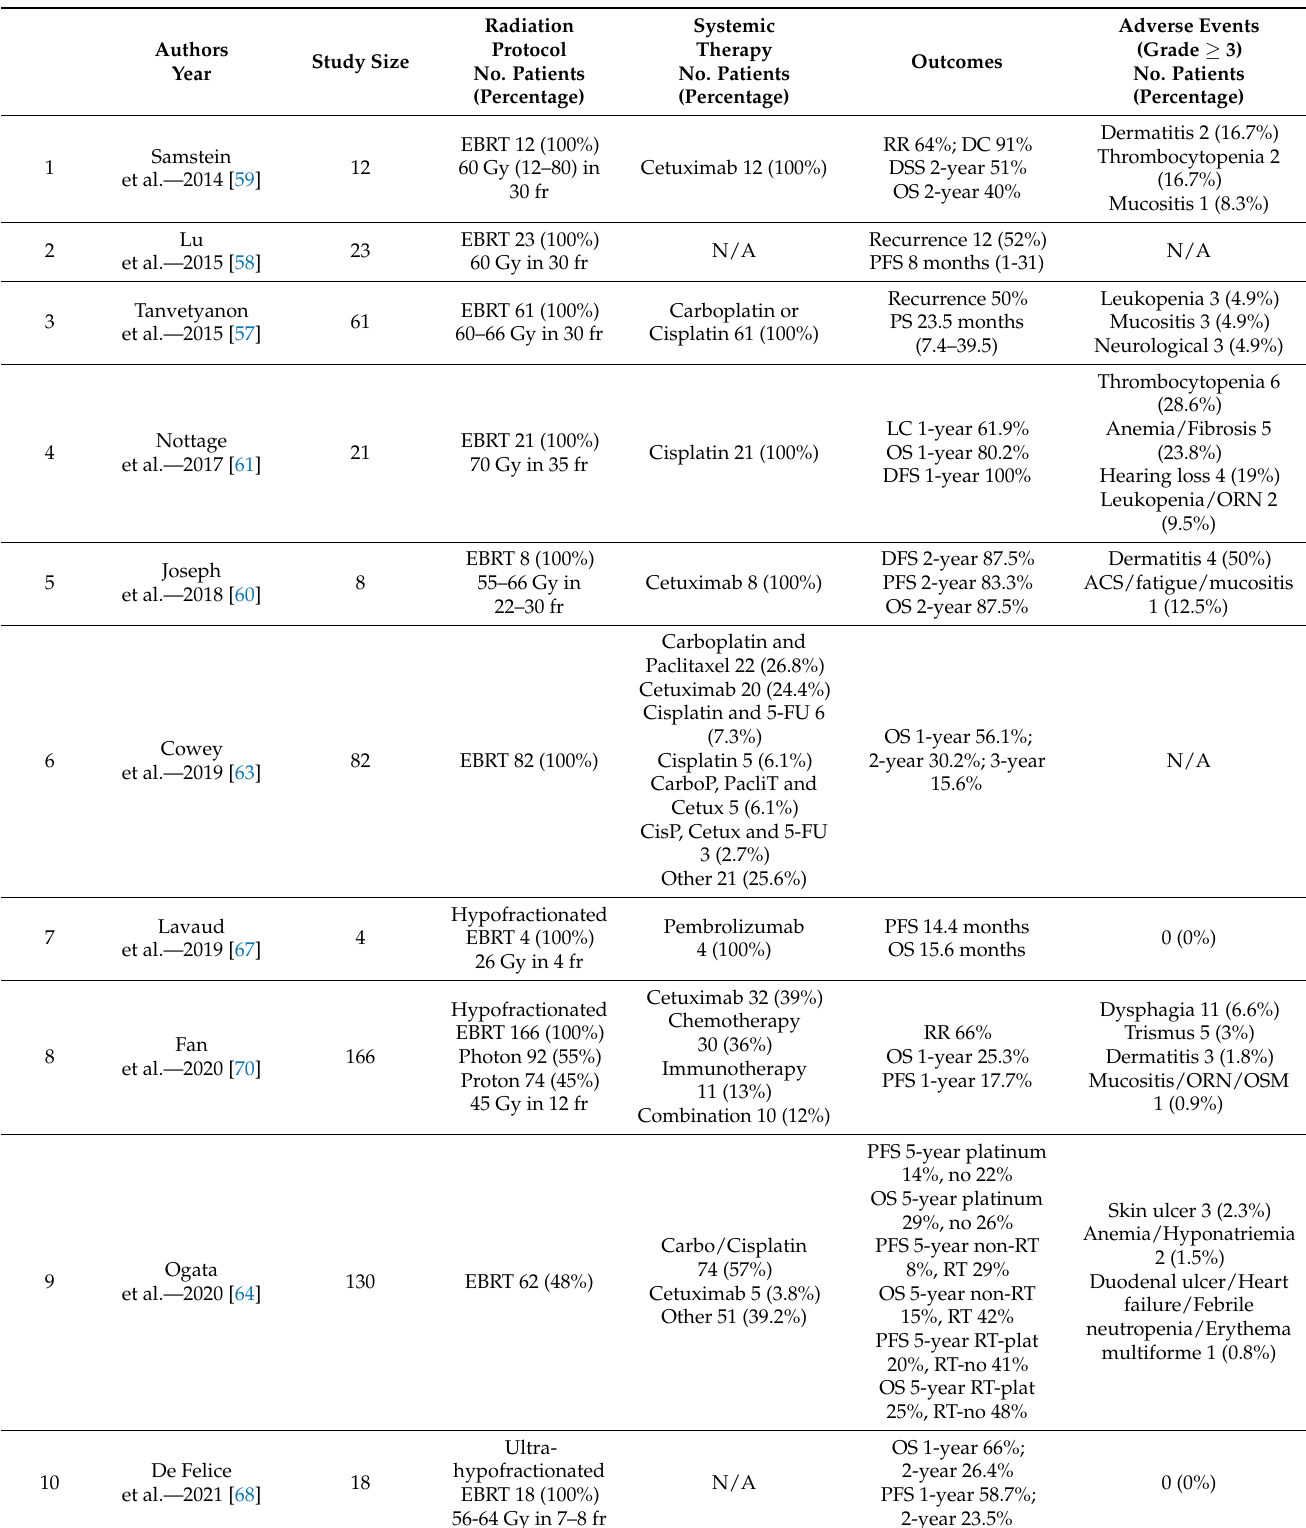
Table 2. Overview of studies including patients with inoperable locally advanced cutaneous squa- mous cell